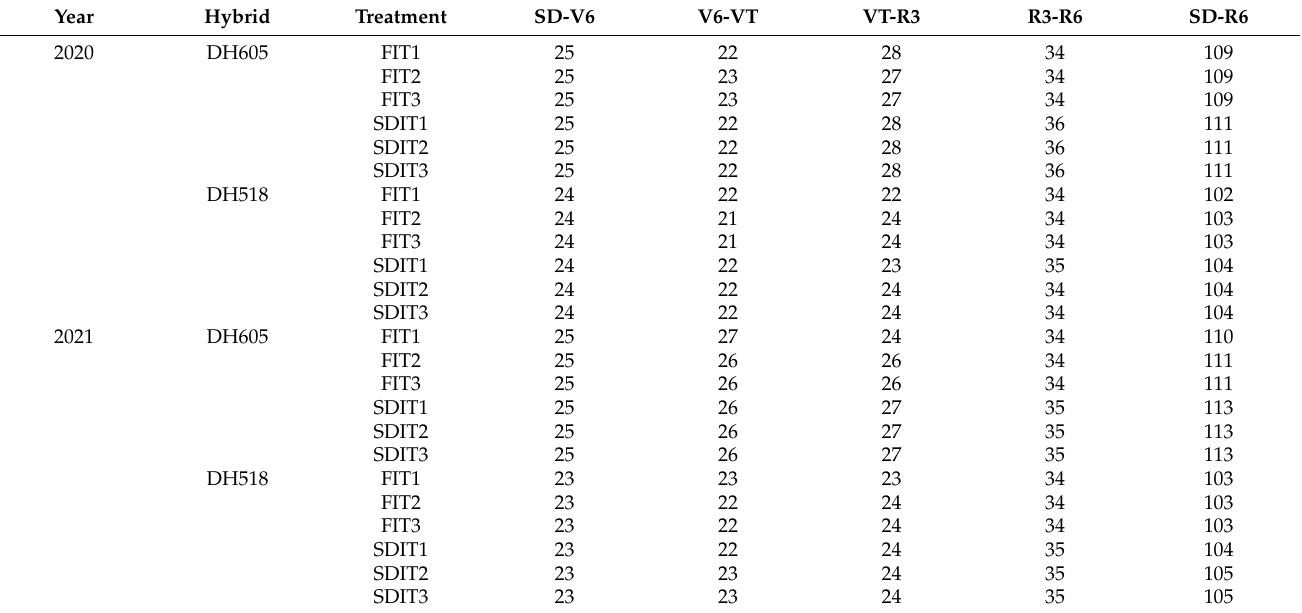
Table 2. Corn phenology (from sowing date to physiology maturity, SD-R6) for two corn hybrids differing in maturity under different irrigation treatments